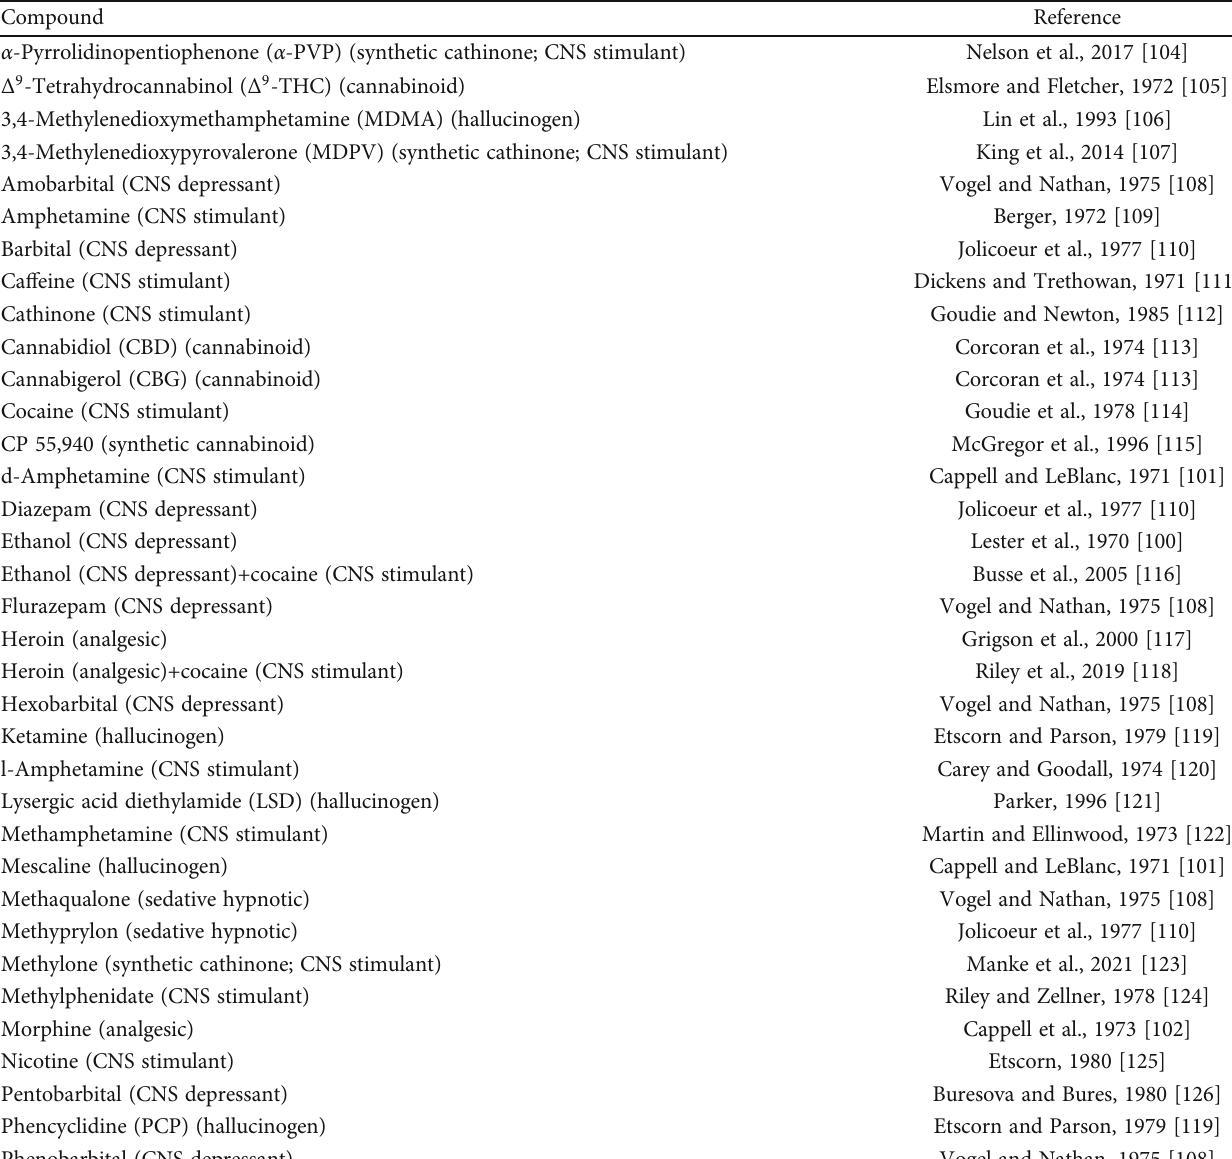
Table 2: Drugs of abuse that are e ff ective in producing a CTA. Each drug has the reference for one of the initial studies examining that speci fi c